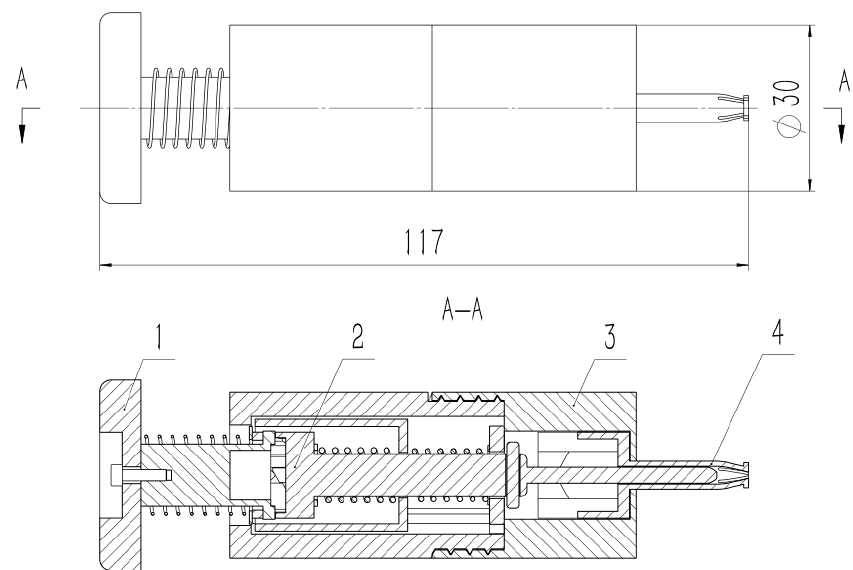
Figure 1. The overall structure of quick-press self-locking temporary fasteners. 1—Button, 2—Transmission assembly, 3—Shell, 4—Clamping assembly.